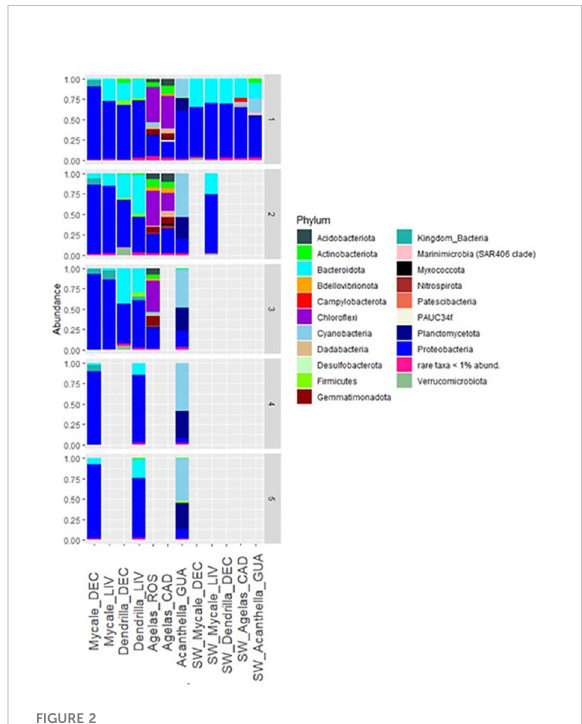
FIGURE 2 Taxonomic af fi liation of ASVs detected in sponge species and seawater in their natural habitat at Phylum level. DEC, Deception Island; LIV, Livingston Island; ROS, Roses; CAD, Cadaque ́ s; GUA, Guam; SW, seawater. Numbers on the right axis indicate sample